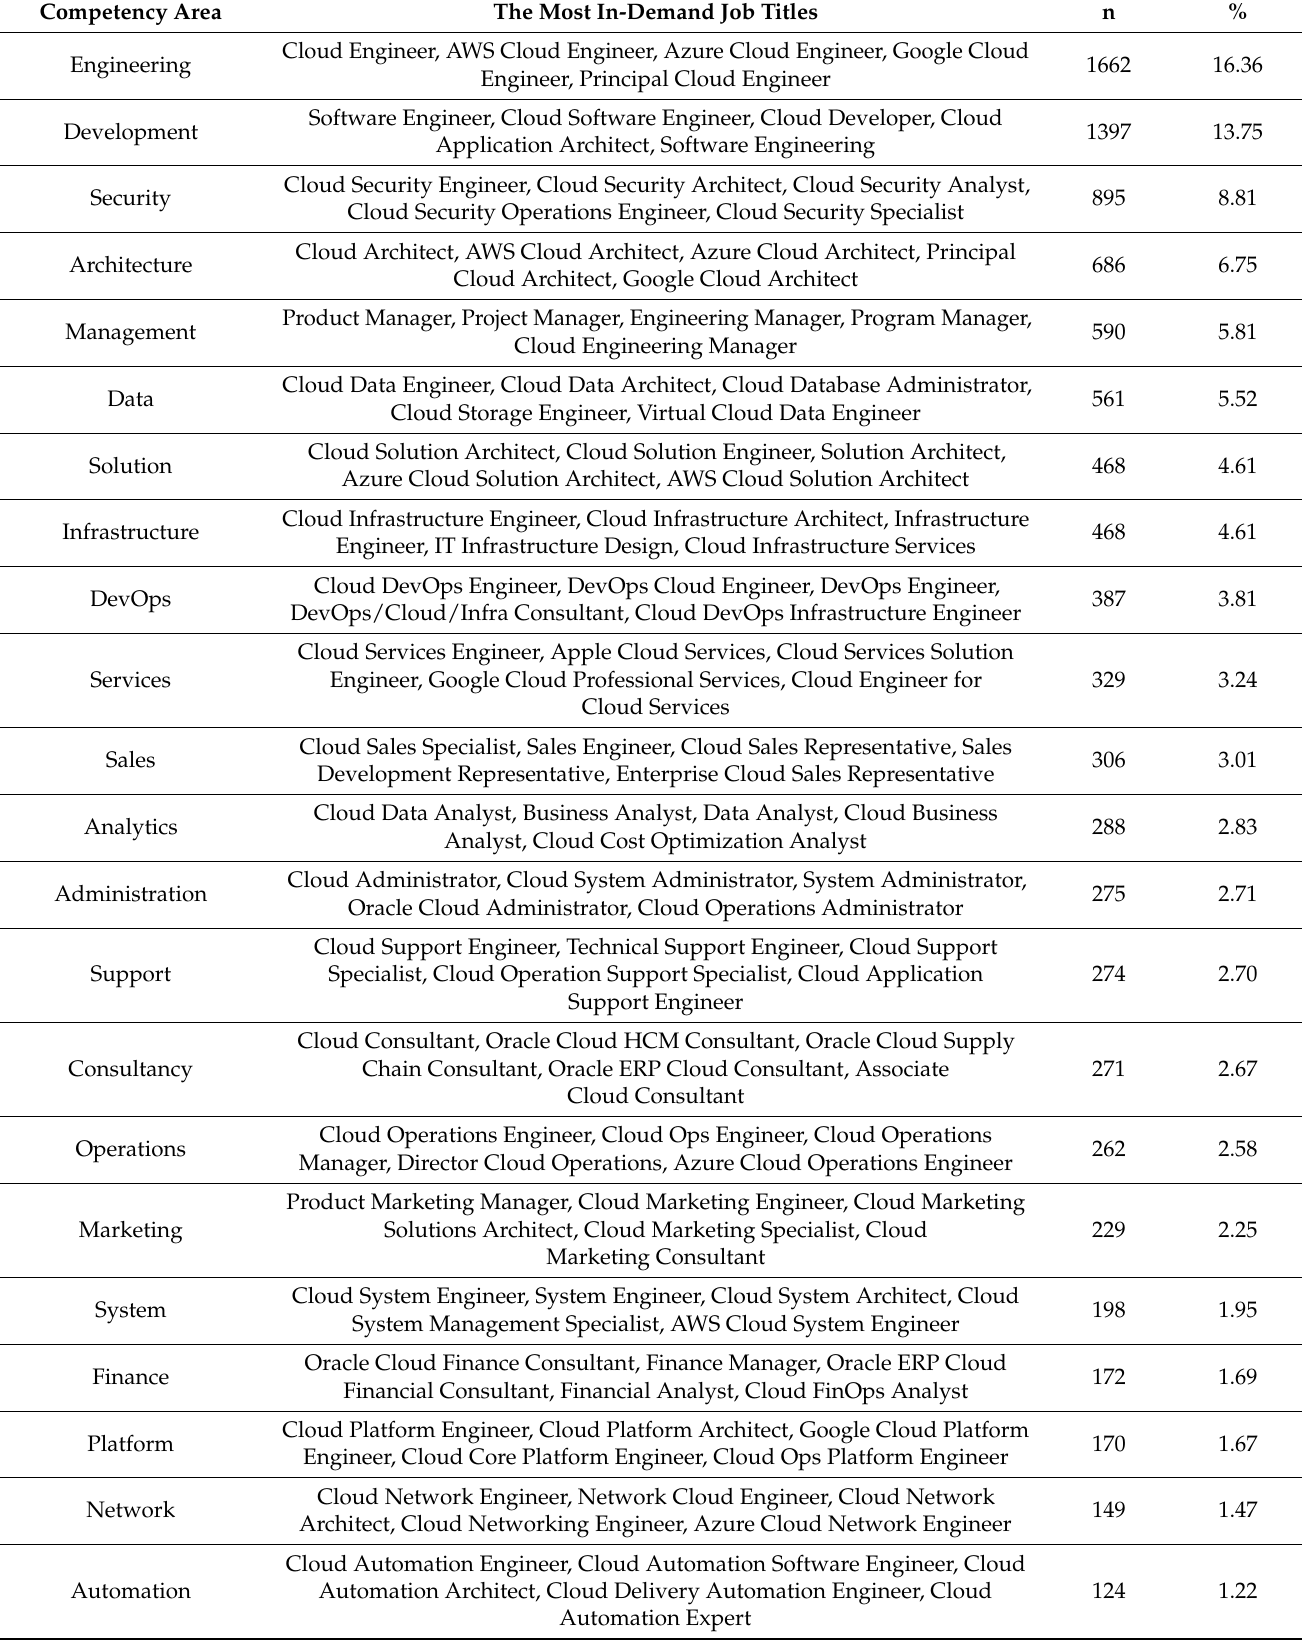
Table 1. Competency areas, related job titles, numbers, and